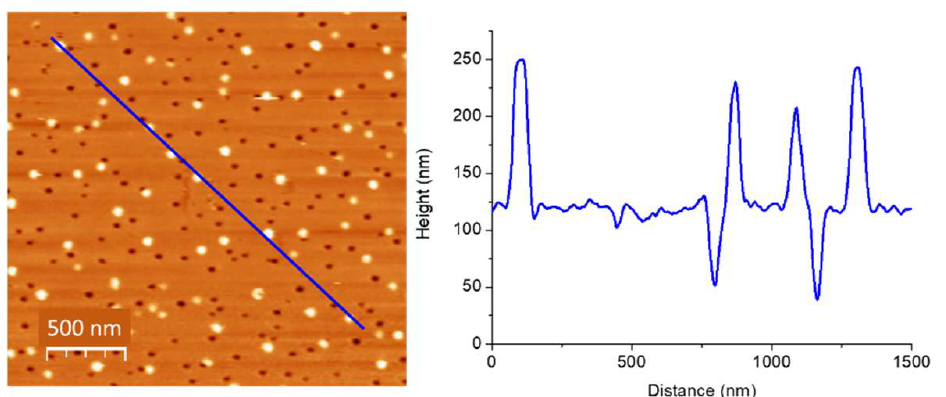
Figure 1. AFM image and its profile for gold nanoparticles embedded in PMMA nanoporous layer using 100 mM of NaAuCl 4 · 2H 2 O dispersed in a mixture of ethanol, acetone, and PMMA. In particular, in order to produce gold nanocubes that require fast kinetics, we used highly volatile solvents (acetone and ethanol), which evaporate rapidly and accelerates the growth rate of NPs as previously established [26]. To fabricate another shape, we tried to change the kinetics rate of formation of GNPs. Starting from this point, we replaced acetone by methyl iso-butyl ketone (MIBK). The samples in Figure 2 were prepared using the same spin-coating parameters (speed 5000 rpm) and NaAuCl 4 as gold precursor molecule. As a result of changing the PMMA solvent from acetone (Figure 2a) to MIBK (Figure 2b)